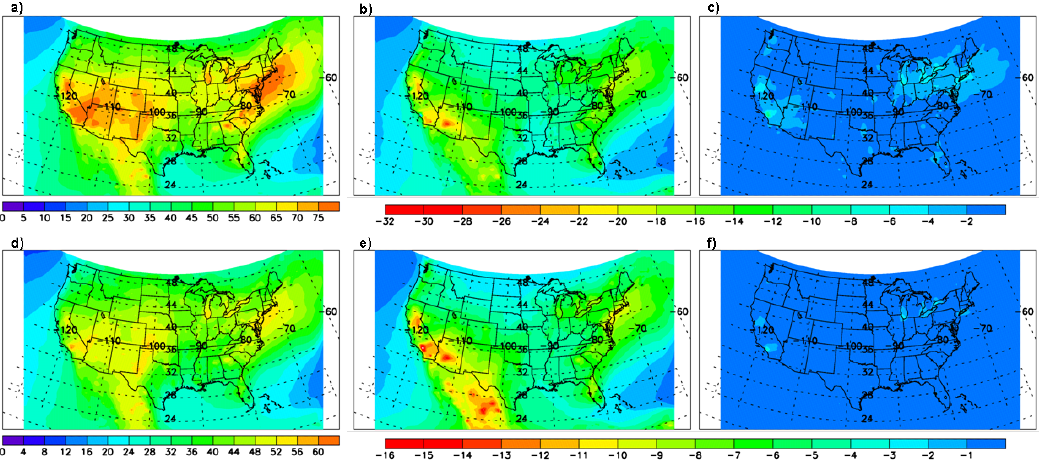
-ICE) scenarios (b, c, e 4 2